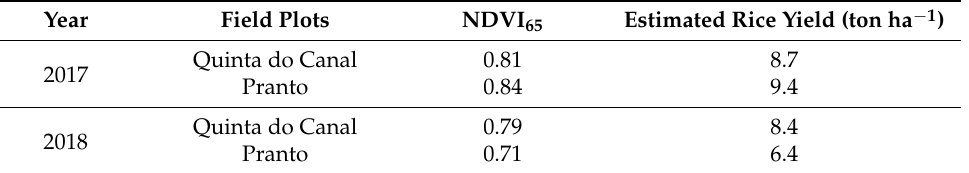
Table 7. Quinta do Canal and Pranto rice field plots’ NDVI values ≈ 65 days after sowing (NDVI 65 ) estimated from Sentinel-2 satellite imagery and rice yield estimated using the predictive model proposed by Siyal et al. (2015) [89]. The data are for 2017 and 2018. Year Field Plots NDVI 65 Estimated Rice Yield (ton ha − 1